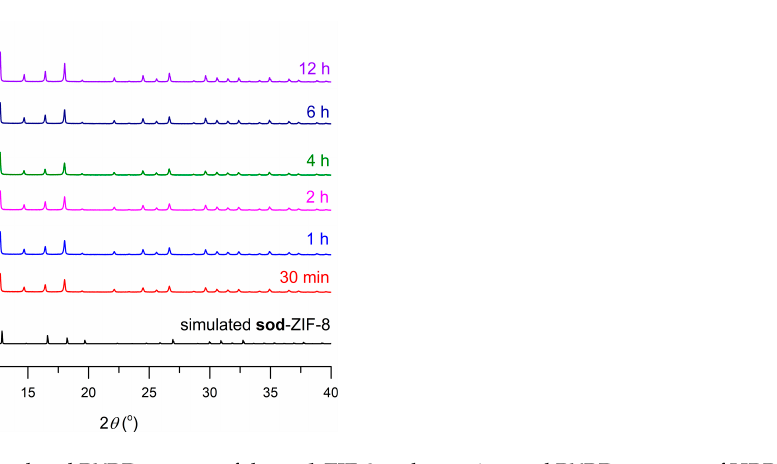
Figure A2. Simulated PXRD pattern of the sod ‐ ZIF ‐ 8 and experimental PXRD patterns of HRP@ZIF ‐ 8 samples obtained during different reaction times.